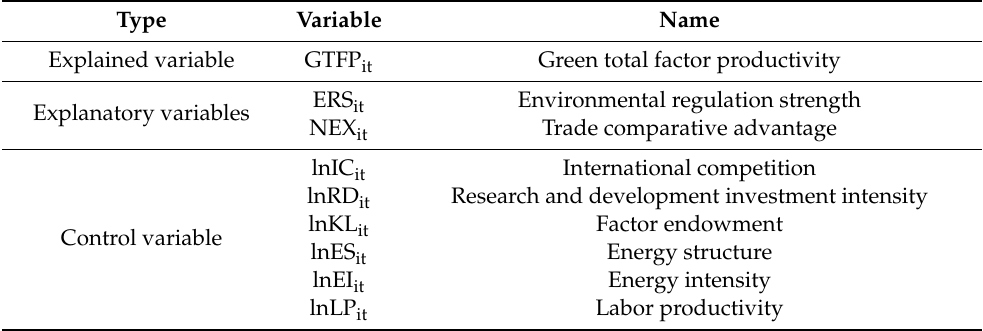
Table 1. The selection results of variable